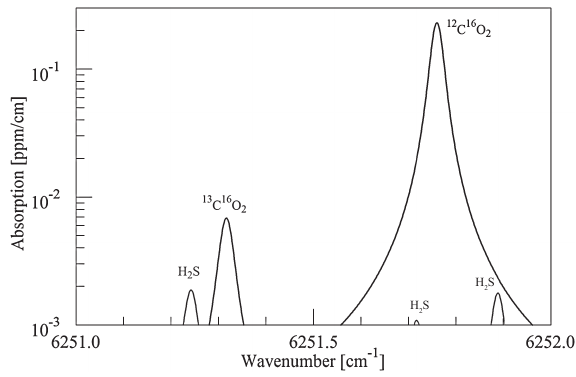
Figure 9. HITRAN model for 400ppm CO 2 and 1ppm H 2 S (45 ◦ C, 140Torr) illustrates the overlapping of H 2 S lines with CO 2 lines. The relative magnitude of H 2 S interference is much larger for 13 CO 12 CO 2 than for 2 . Note the logarithmic